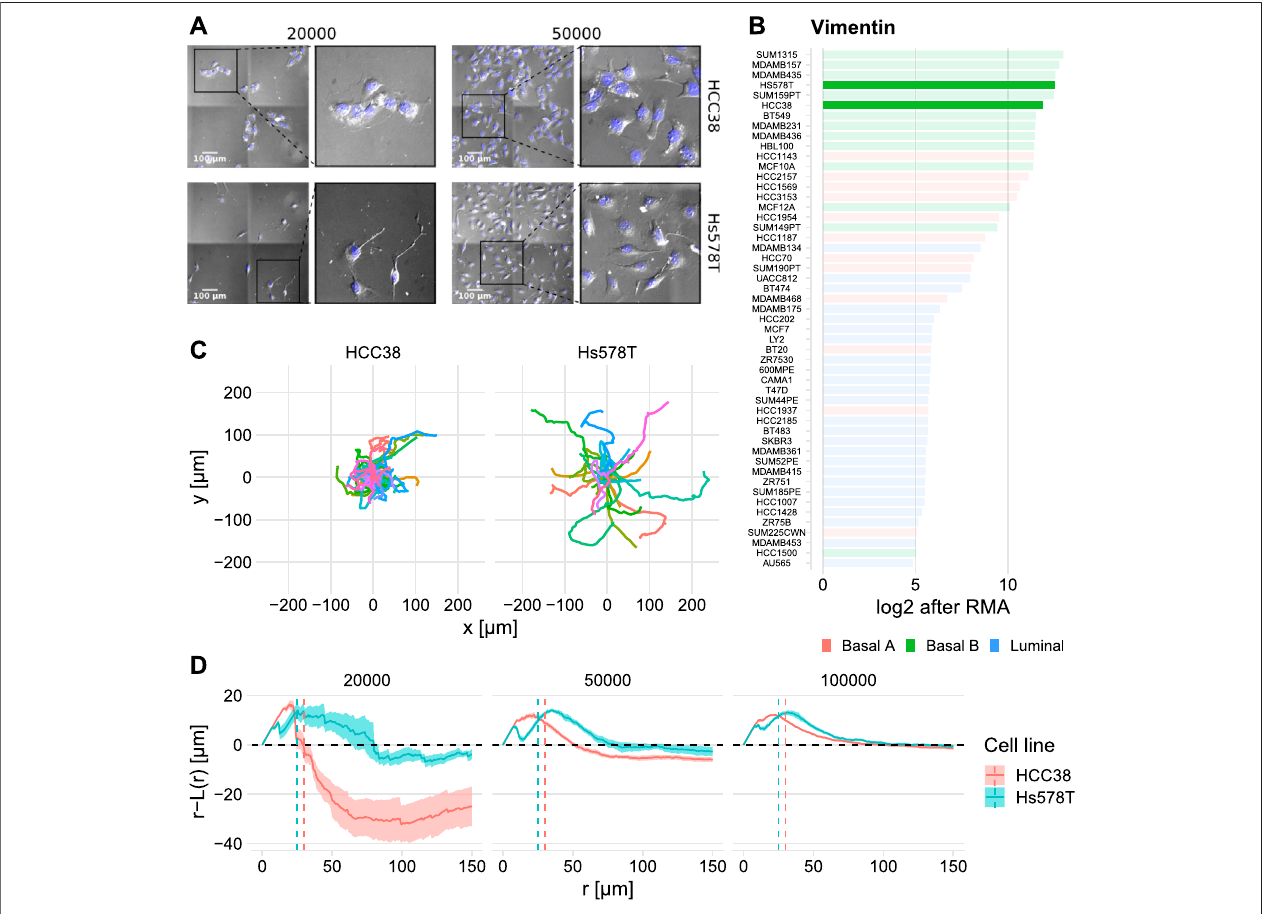
FIGURE2| Quanti fi cationofobserveddynamicclusteringofHCC38cells. (A) StillimagesofHCC38(toprow)andHs578T(bottomrow)atthetwolowestdensities att ≈ 10 h(insetsshowzoom-ins). (B) VimentinexpressionofacollectionofBCcelllines(datafromNeveetal.,2006).Valuesareinlog2afterRobustMulti-arrayAverage (RMA). (C) Differenceinmaximumoutreachofcellsillustratedbynormalized trackplots(i.e.,thestartingpointismovedtotheorigin).Datadisplayedfromthesamewells as (A) left column. (D) Spatial statistics visualization of HCC38 and Hs578T using the Ripley L function (see Section 4.5 for details) at t ≈ 10 h. The dashed line r − L ( r )=0showsthetheoreticallyexpectedoutcomeincaseofcompletespatialrandomness,valuesaboveandbelowthislinesignifydispersionandclustering.Thevertical dashed lines denote approximate nuclei diameters.